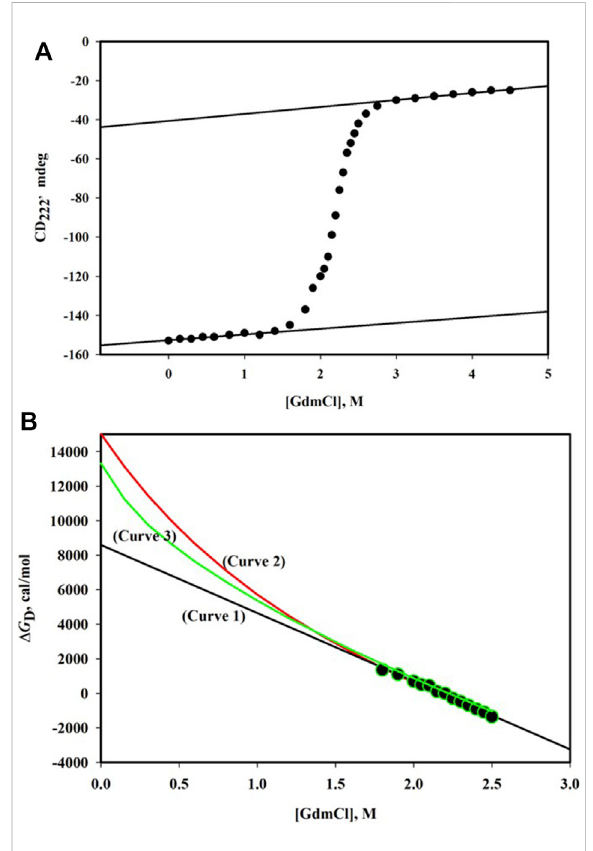
FIGURE 1 (A) GdmCl-induced denaturation curve monitored by CD 222 of α -phycoerythrin at pH 7.0 and 25 ° C. The protein concentration was 0.75 mg/ml and path length of the cell was 0.1 cm. The linear dependenceofthepre-transitionbaselineisdescribedbythe relation,CD 222 =-152.6+2.90[GdmCl].Thelineardependenceof the post-transition baseline is described by the relation, CD 222 = -40.5 + 3.57 [GdmCl]. (B) Plot of Δ G D versus [GdmCl]. Observed data ( fi lled circles) were analyzed using three models of denaturation (see text). The best fi t parameters are as follows: m = 3.94 (±0.09) kcal/mole. M Δ G D 0 = 8.58 (±0.20) kcal/mole and for the linear model (curve 1); Δ G D 0 = 15.03 (±0.46) kcal/mole, Δ n = 48 (±1), and k = 0.7 for the binding model (curve 2); and Δ G Δα = 0.31 (±0.01) for the D 0 = 12.90 (±0.14) kcal/mole and transfer-free energy